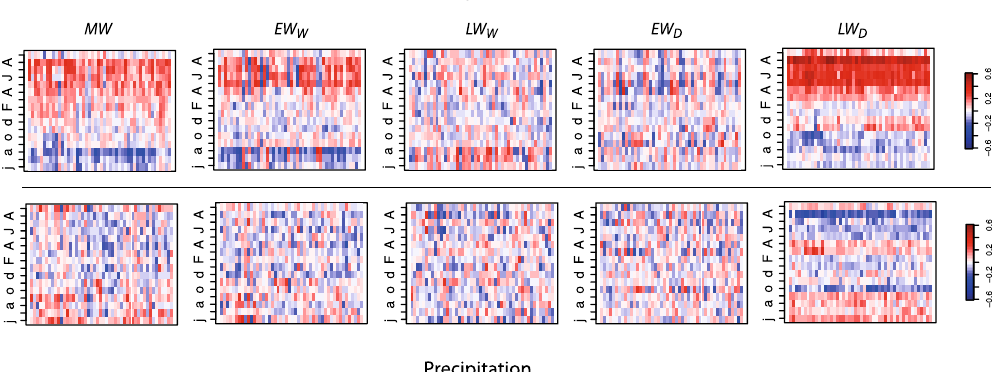
Figure 3. Pearson correlation coefficients for MW (top) and the four variables used in the calculation of MW : EW W , LW W , EW D and LW D at each site investigated (N = 48, sites on the x-axis, ranked (from left to right) from 1 to 48).